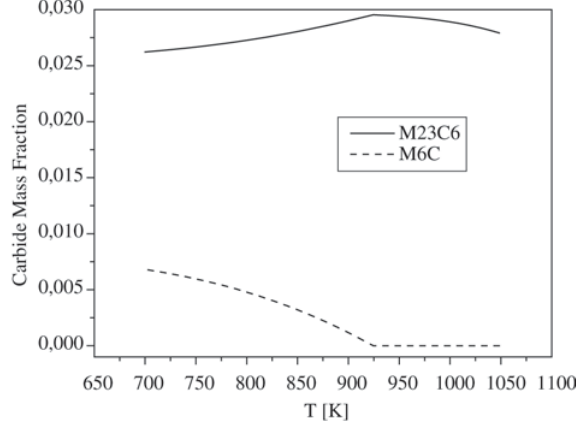
Figure 5. Theoretical mass fraction of the thermodynamically sta- ble carbides M-